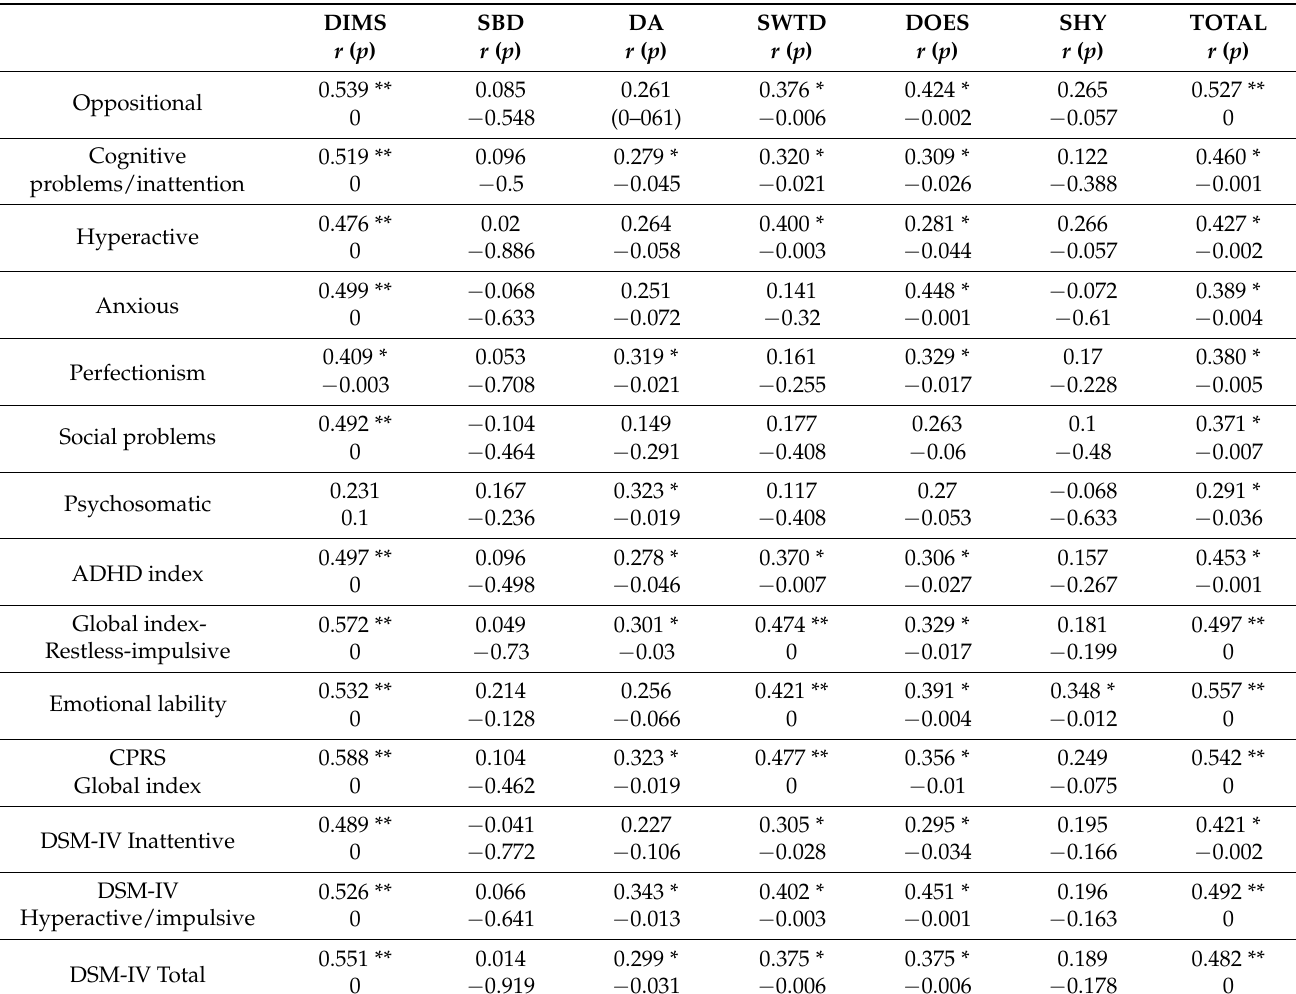
Table 2. Association between sleep problems and symptoms of attention-deficit/hyperactivity disorder. * p < 0.05; ** Survived after Bonferroni correction p ≤ 0.001.